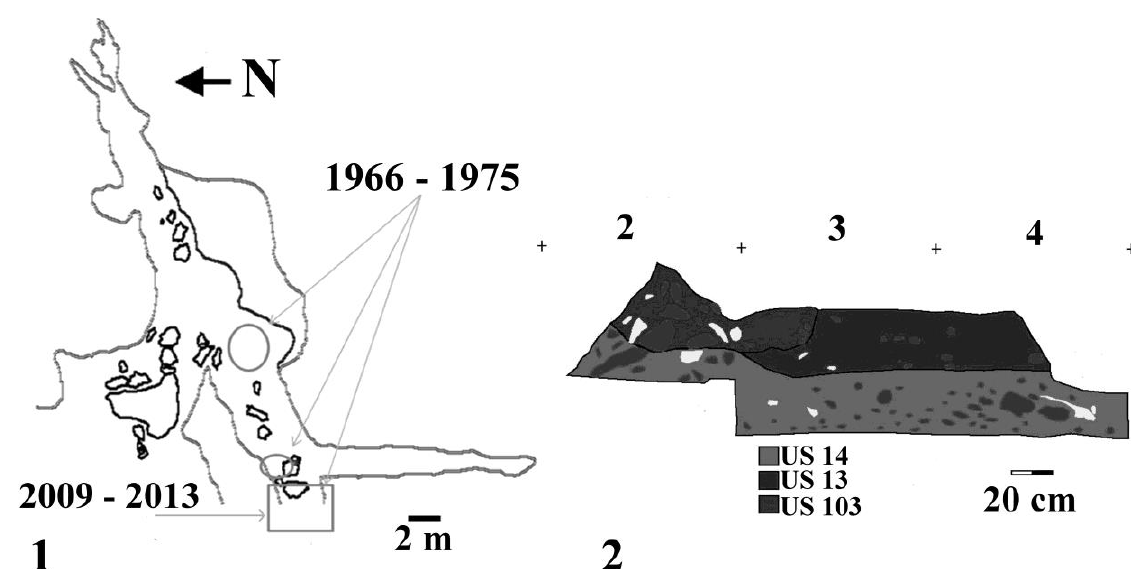
Figure 2. 1. Planimetry of the Ciota Ciara cave. 2. Longitudinal section G/F.